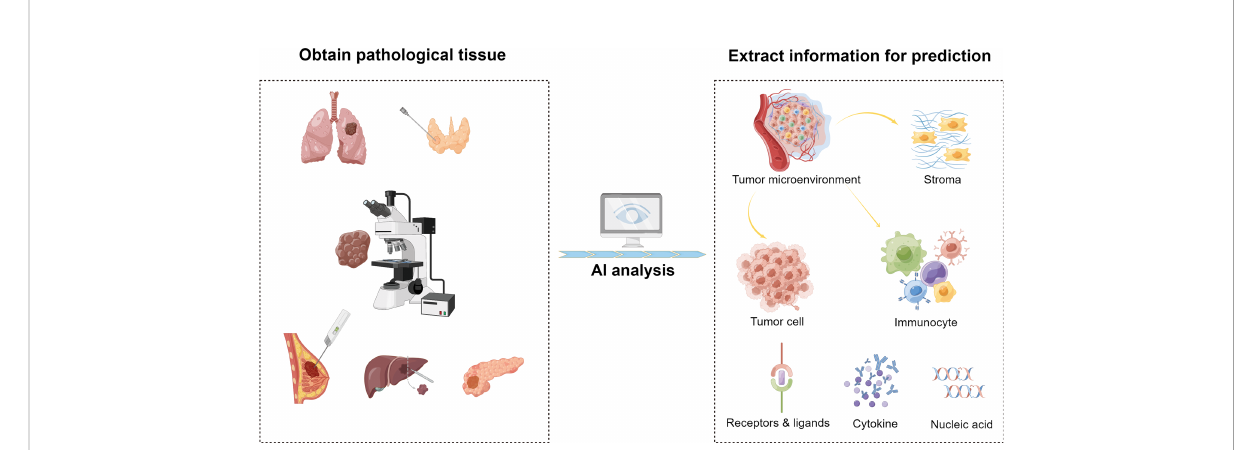
FIGURE 2 AI-based evaluation of immunotherapy ef fi cacy by histopathological features. This is an illustration of the use of AI to forecast the effectiveness of immunotherapy. With the help of AI, more speci fi c information can be extracted from clinical pathological tissues, including components of the tumor microenvironment and small molecular components like receptors, ligands, cytokines, nucleic acids, etc. From these elements, AI gathers data related to immunotherapy to forecast the ef fi